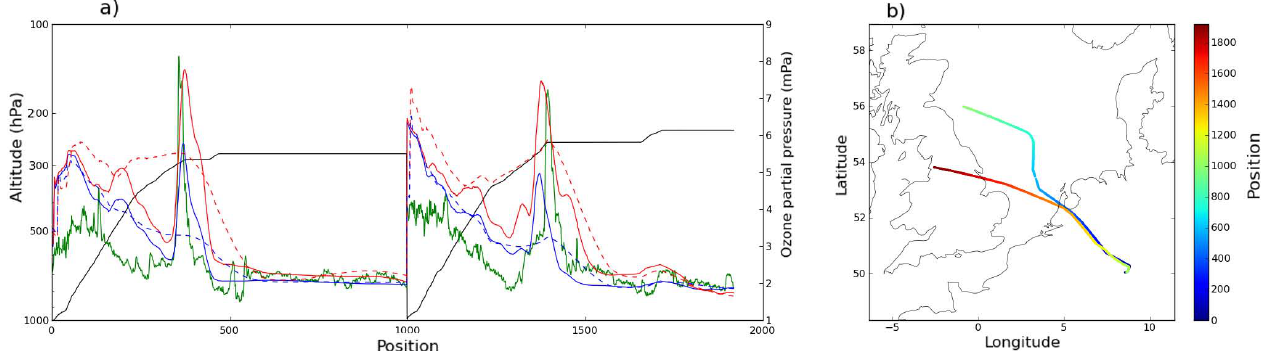
Fig. 5. Left hand side panel: ozone data from MOZAIC (green line), free MOCAGE run (blue lines) and analyses fields (red lines), in mPa (10 − 3 Pascals, right hand side y-axis); flight level (black line), in hPa (10 2 Pascals, left hand side y-axis). Low resolution (2 ◦ ) and high resolution (0.2 ◦ ) results are marked as dashed lines and solid lines, respectively. Right hand side panel: flight tracks on 23 June 2009. Position 0 to 1000: starting at Frankfurt (50 ◦ N, 8 ◦ E, Germany, 08:13UT) to Calgary (51 ◦ N, 114 ◦ W, Canada). Position 1000 to 1900: starting at